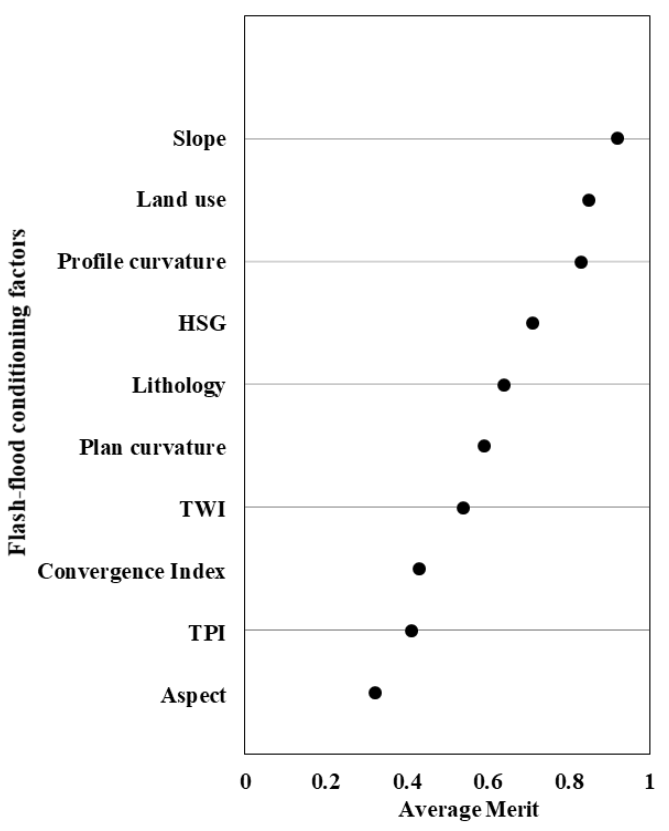
Figure 8. Predictive ability of the ten flash-flood predictiors.